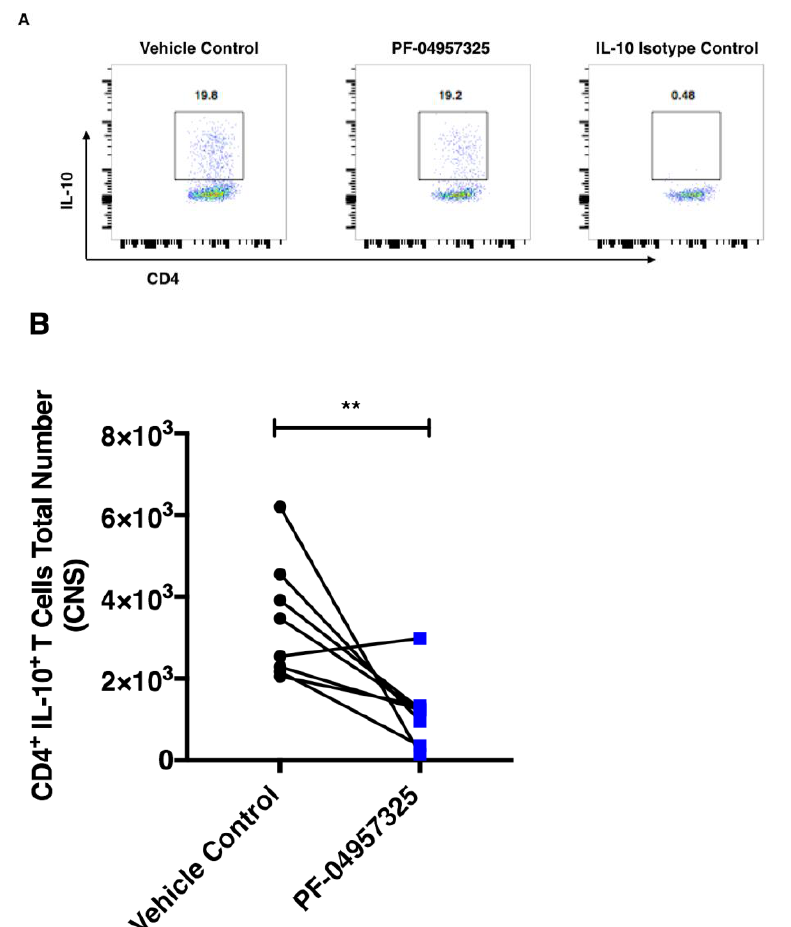
Figure 7. Treatment with PF-04957325 suppresses the accumulation of IL-10-producing CD4 + T cells in the spinal cord. Mice with EAE scores of at least 1 were treated with the vehicle control or PF-04957325 thrice daily, for 6 to 13 days. ( A ) The detection of IL-10 + CD4 + cells after ex vivo restimulation with PMA/Ionomycin by flow cytometry in the spinal cord mononuclear cells (CNS) of EAE mice treated with the vehicle control or PF-04957325. The representative dot plots show that CD4 + T cells ( x -axis) that are positive for IL-10 + ( y -axis) show comparable frequencies in the vehicle- and inhibitor-treated mice (** p = 0.002). ( B ) The data represent the total number of IL-10 + CD4 + T cells ( n = eight mice per group, mean ± SEM of three independent experiments).